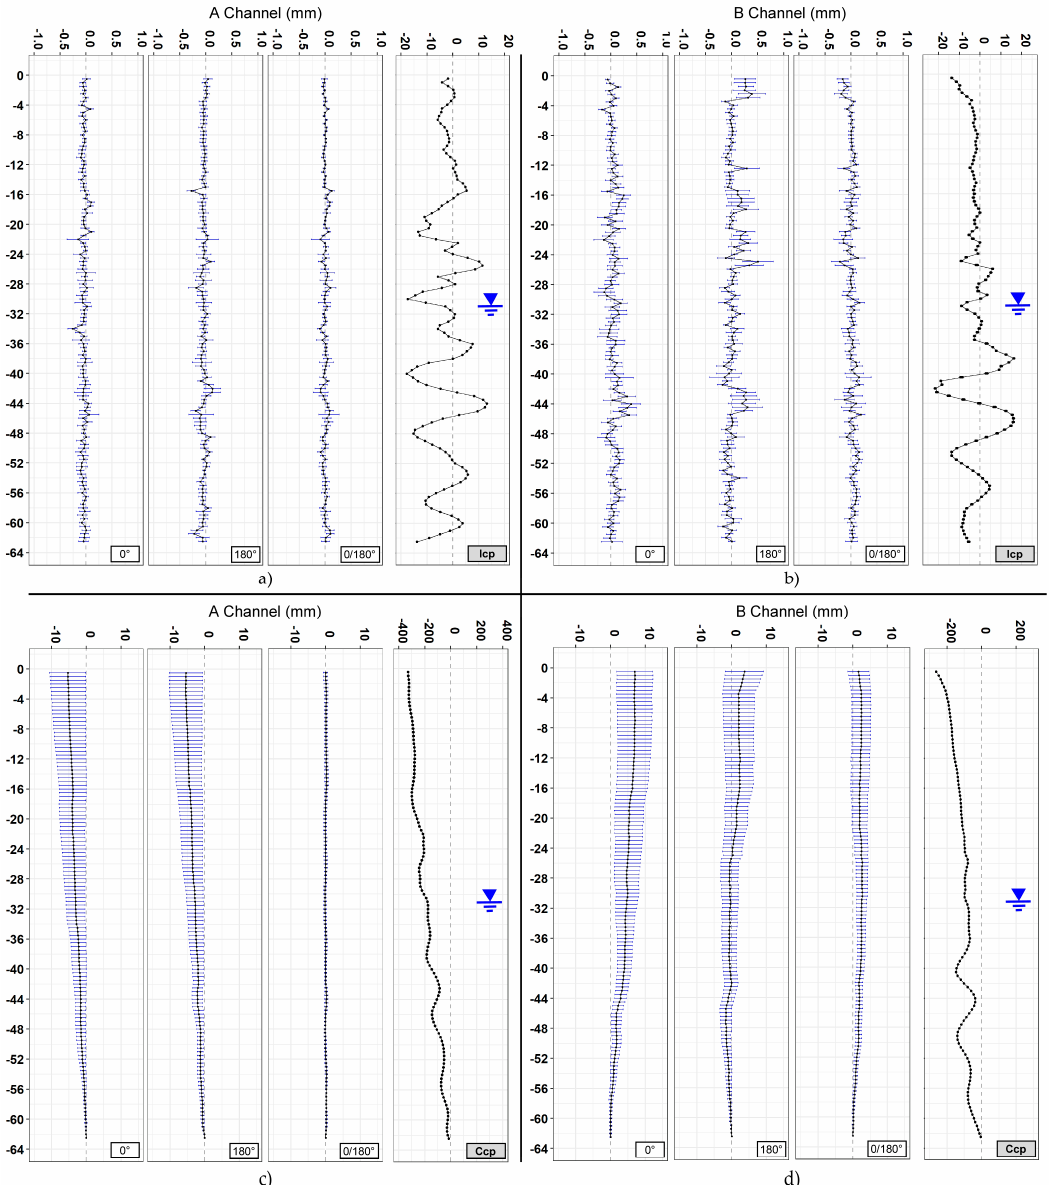
Figure 9. Section 2. ( a ) Incremental displacements for the A channel; ( b ) incremental displacements for the B channel; ( c ) cumulative displacements for the A channel; and ( d ) cumulative displacements for the B channel.